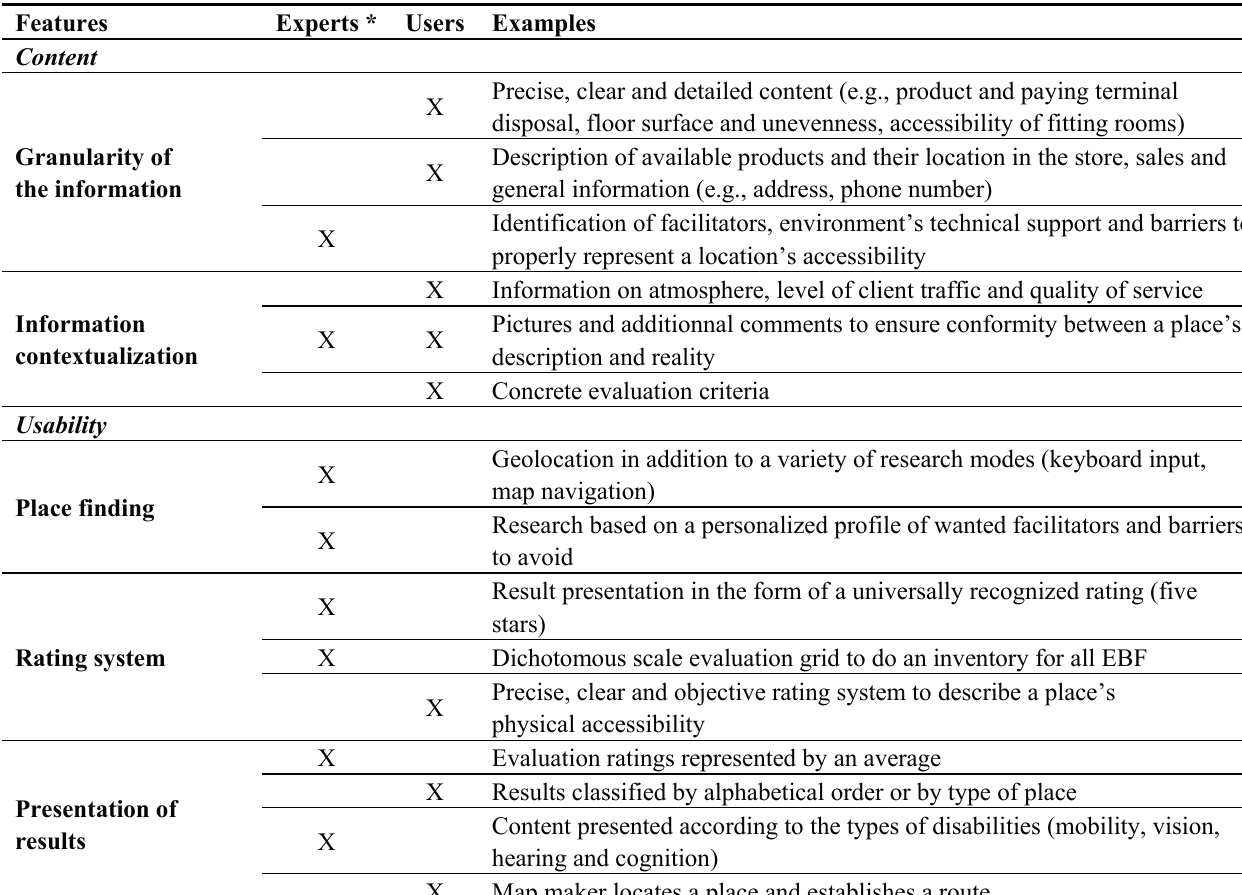
Table 2. Key features of an ideal mobile